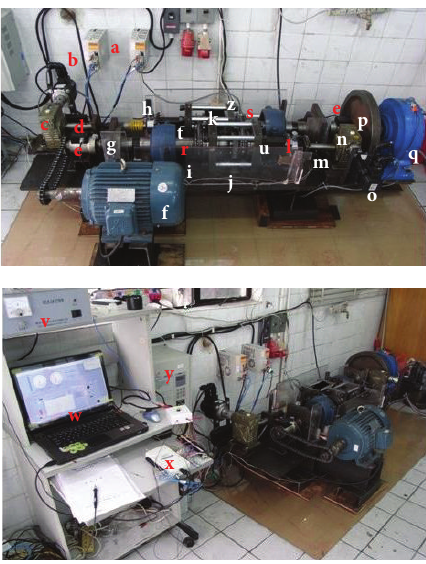
Figure 4: Experimental setup of prototype DBVCVT and test rig.